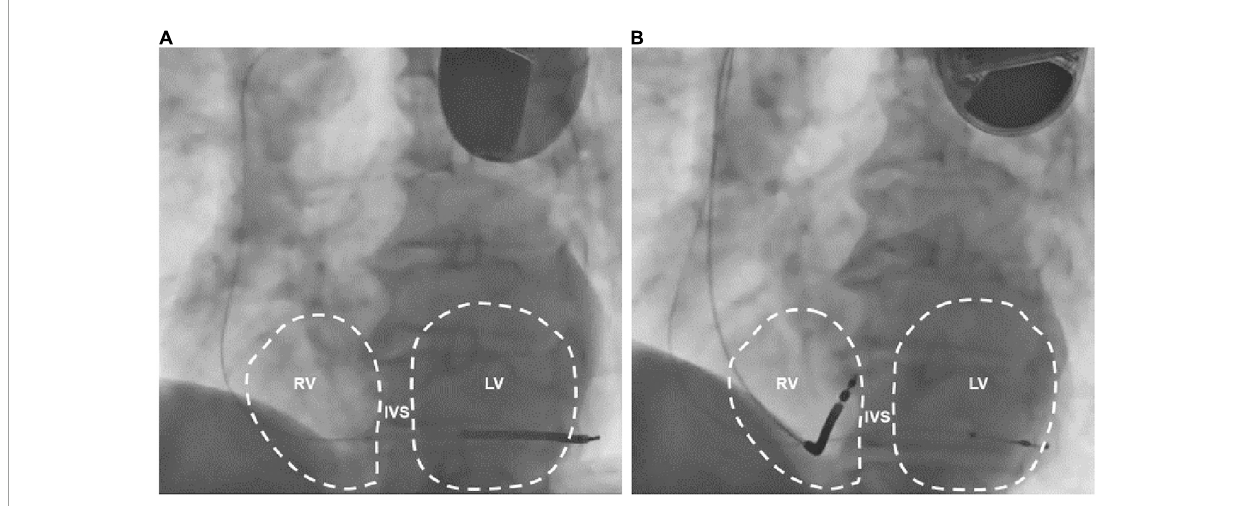
FIGURE4 LAO 45 ◦ fluoroscopic views of the previously implanted single chamber cardioverter defibrillator (A) and the subsequently implanted biventricular cardioverter defibrillator (B) . Note that in A the defibrillation lead crosses the midline toward the left ventricle. LAO: left anterior oblique; RV, right ventricle; IVS, interventricular septum; LV, left